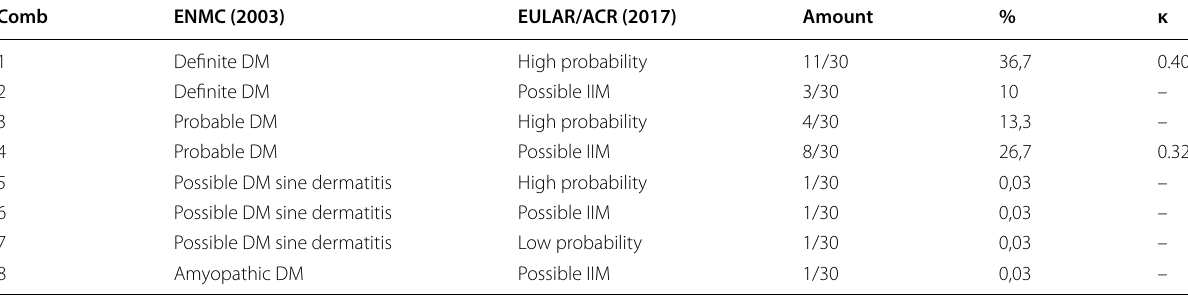
ENMC European Neuromuscular Centre, EULAR European League Against Rheumatism, ACR American College of Rheumatology, DM dermatomyositis, IIM i diopathic inflammatory myopathies